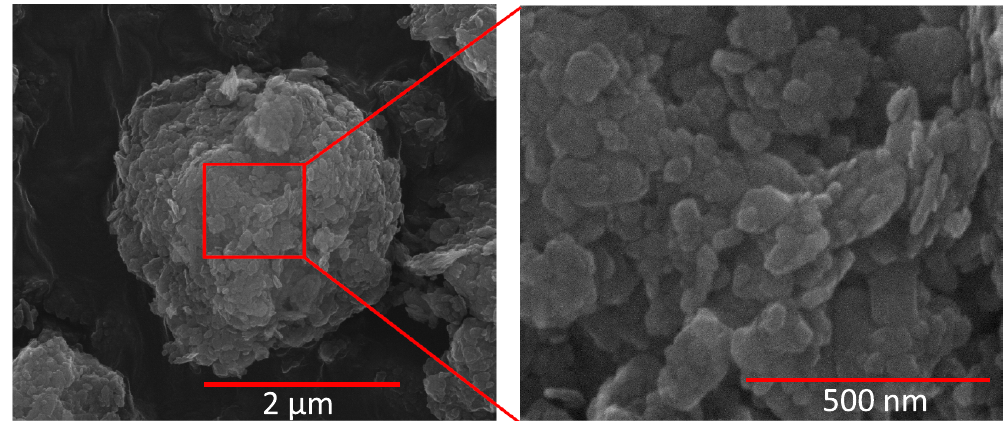
Fig. 2. Scanning Electron Microscope (SEM) images of NX illite. An aggregate of several micrometers in size is shown on the left and a close up (right) reveals that it is composed of many platelets on the order of 10–100s of nanometres across. This is consistent with the gas adsorption measurements which suggested average particles sizes of ∼ 20nm (assuming smooth spheres – see experimental section for